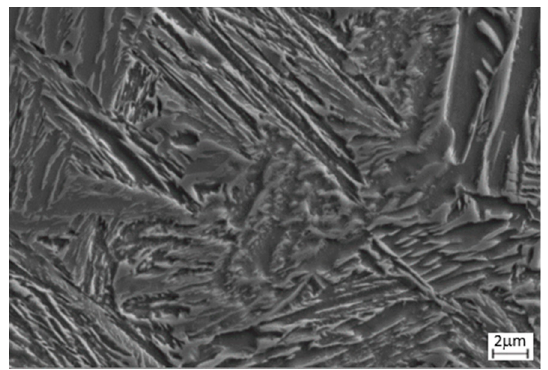
Figure 5. Heat treatment parameters: Soaking 1000 °C/100 s, cooling rate 30 °C/s, bainitic hold 400 °C/600 s. Bainitic microstructure with coarse laths of bainitic ferrite.